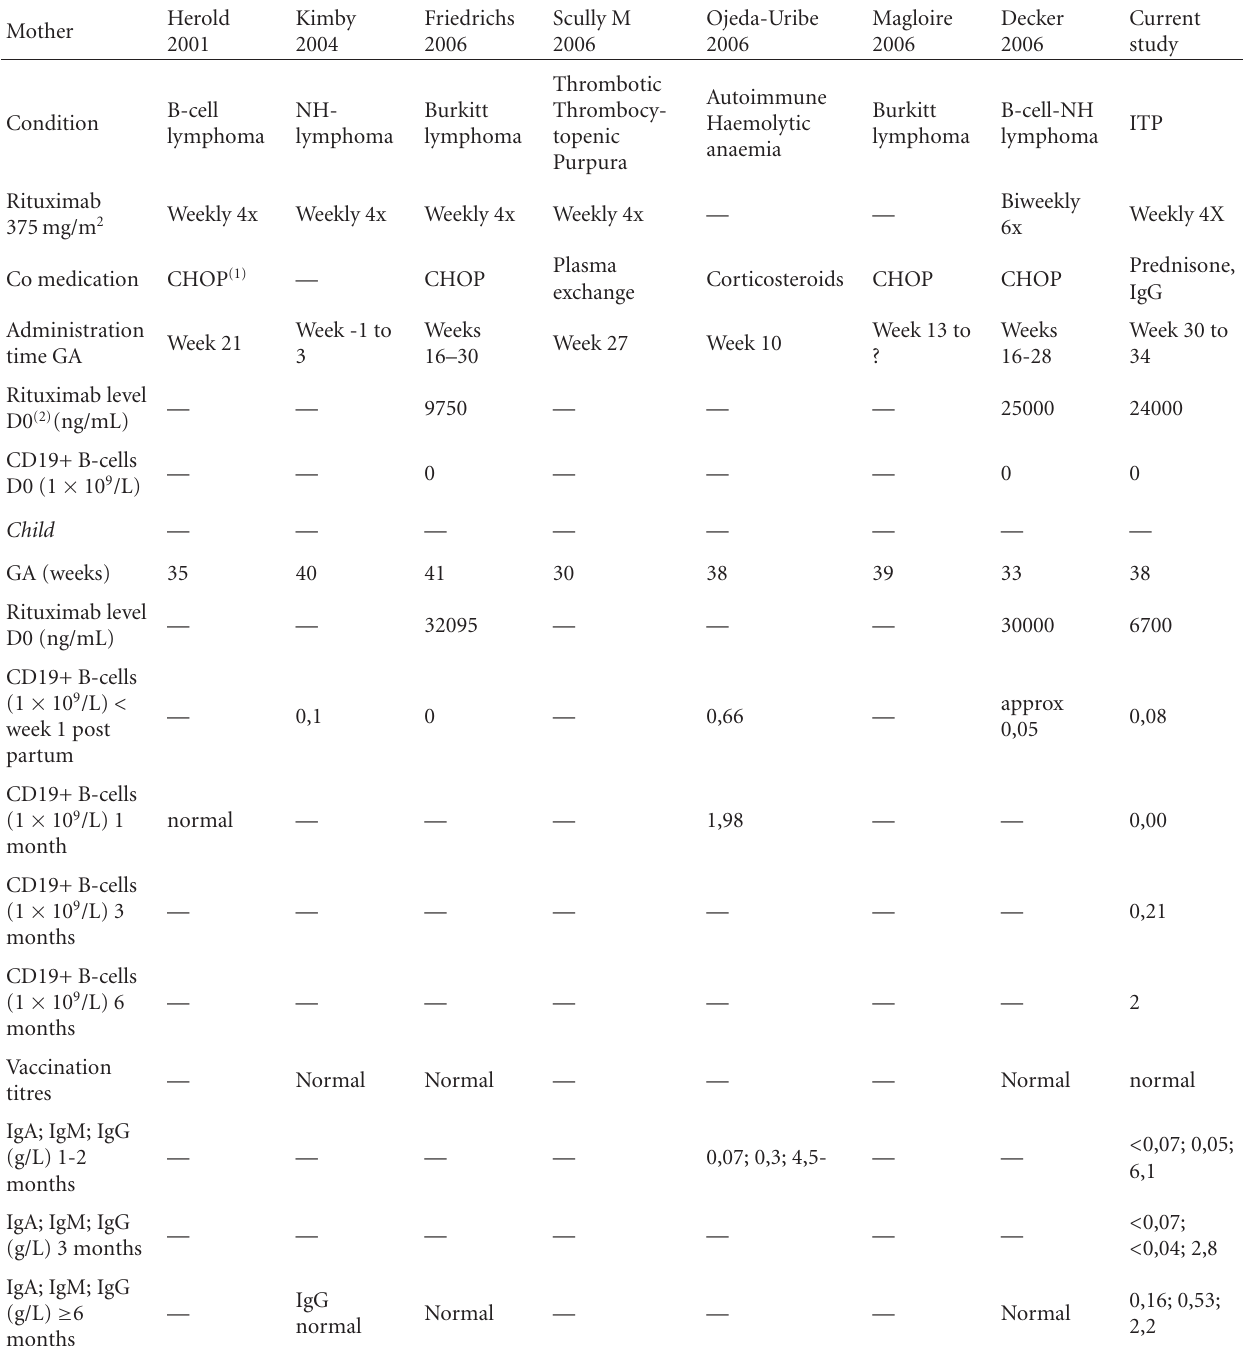
Table 1: Summary literature